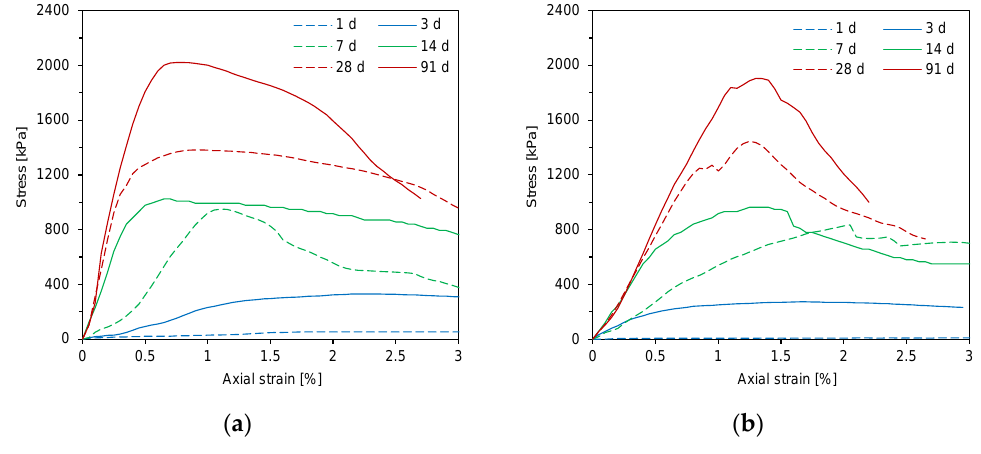
Figure 4. Typical stress–strain curves along the curing time—( a ) M1; ( b ) M5.